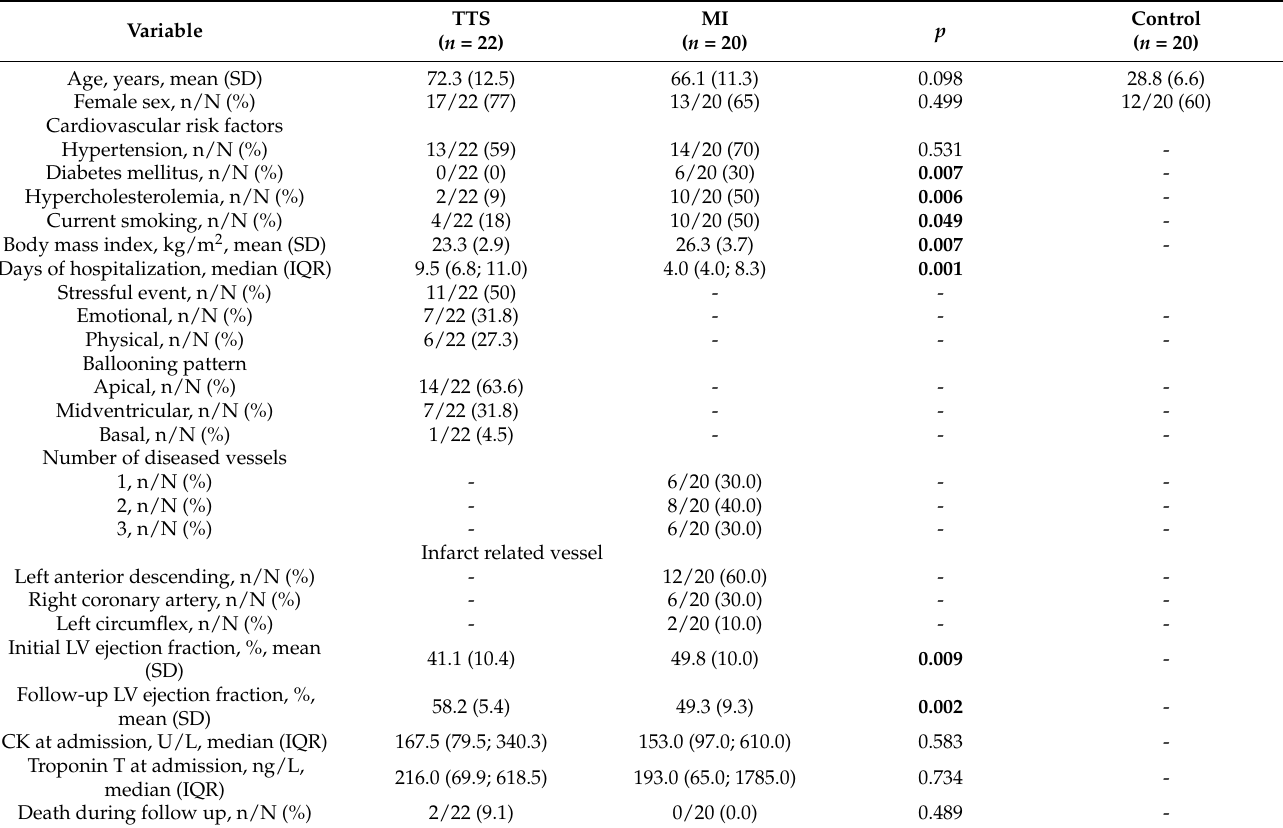
Table 1. Baseline clinical